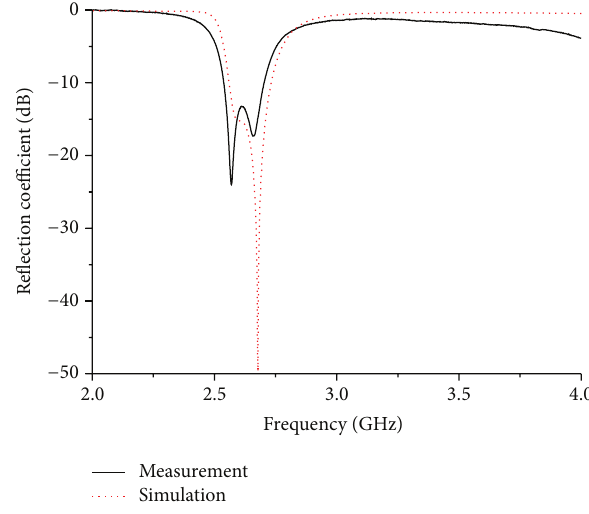
passing on this change on other resonators and on the dif- ferent couplings. This will change the structure, particularly the position of the resonators relative to each other.